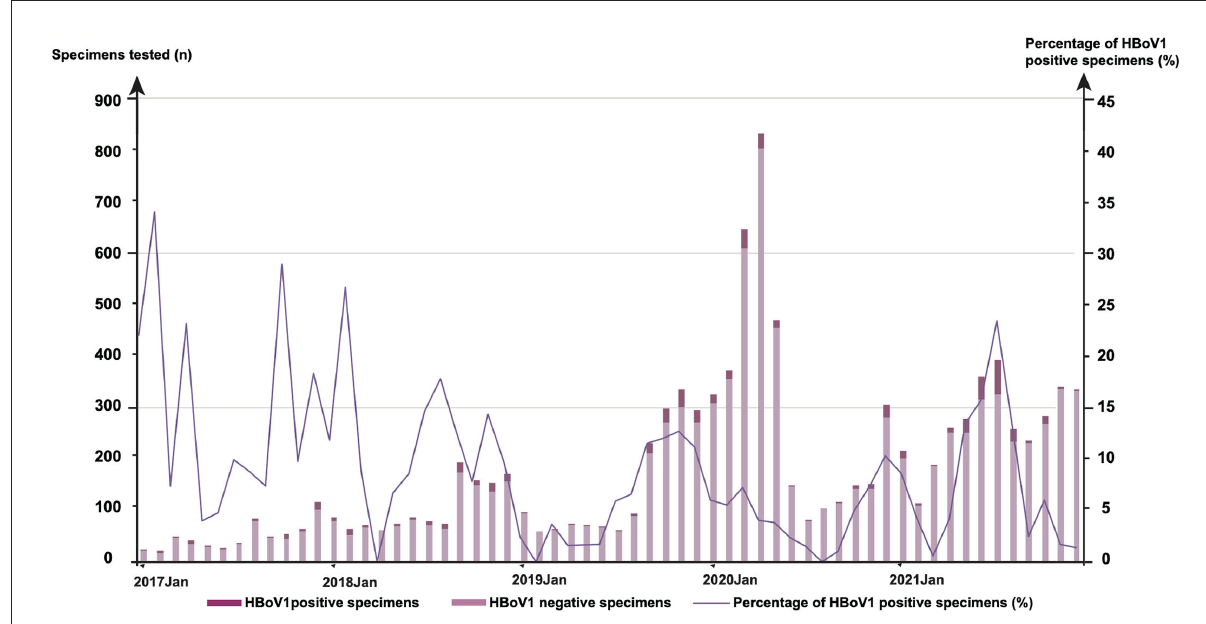
FIGURE1 The monthly distribution of 681 human bocavirus 1 (HBoV1) positive specimens among 9,899 tested from January 2017 to December